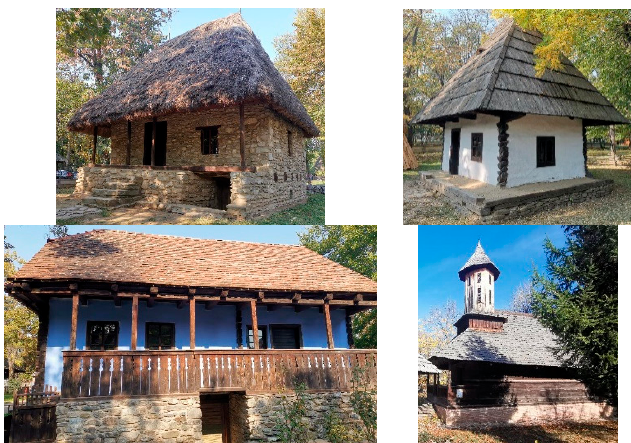
Figure 1. Examples of Romanian traditional buildings incorporating different construction materials (stone, bricks and wood)—pictures belonging to the authors’ private collection.